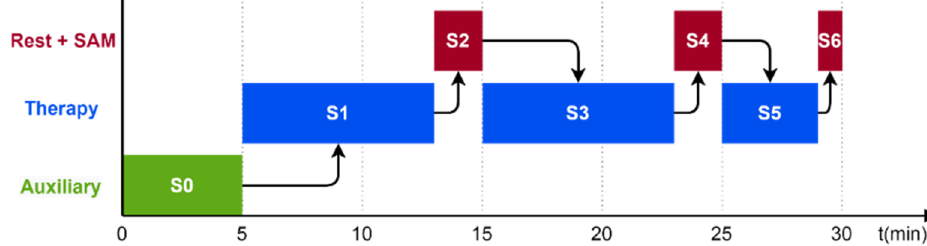
Figure 7. Temporal diagram of the protocol with the sequence of stages and their durations.